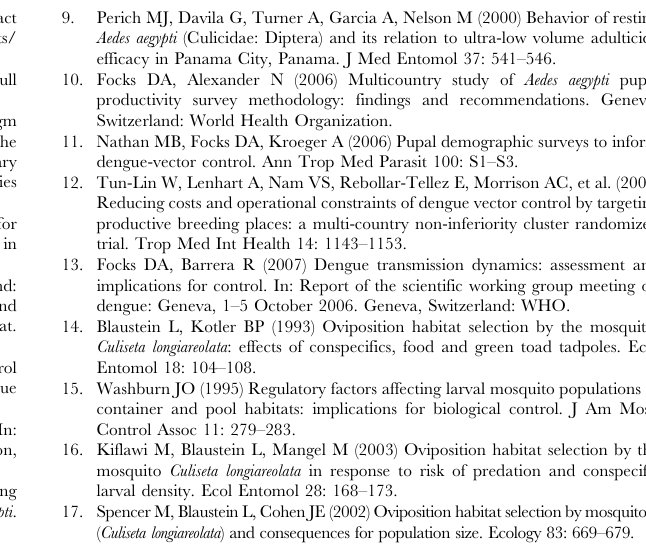
Figure S1 Number of pupae produced per container treatment during preference-performance field experi- ment (mean ± SE). Data include all 80 containers located in the 20 houses. Figure S2 Mean ( ± SE) wing length of males developing in four container treatments. Figure S3 Segment plots depicting when and where individual females deposited their eggs during A) trial 1, B) trial 2, C) trial 3, and D) trial 4. Each circle represents an oviposition container and each column represents a single day (eight containers available each day). The size of the